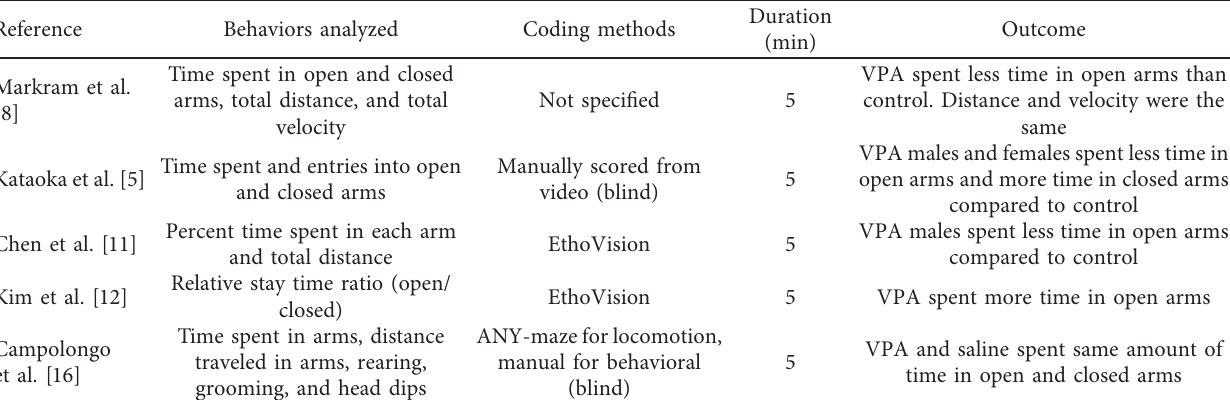
Table 7: Elevated plus